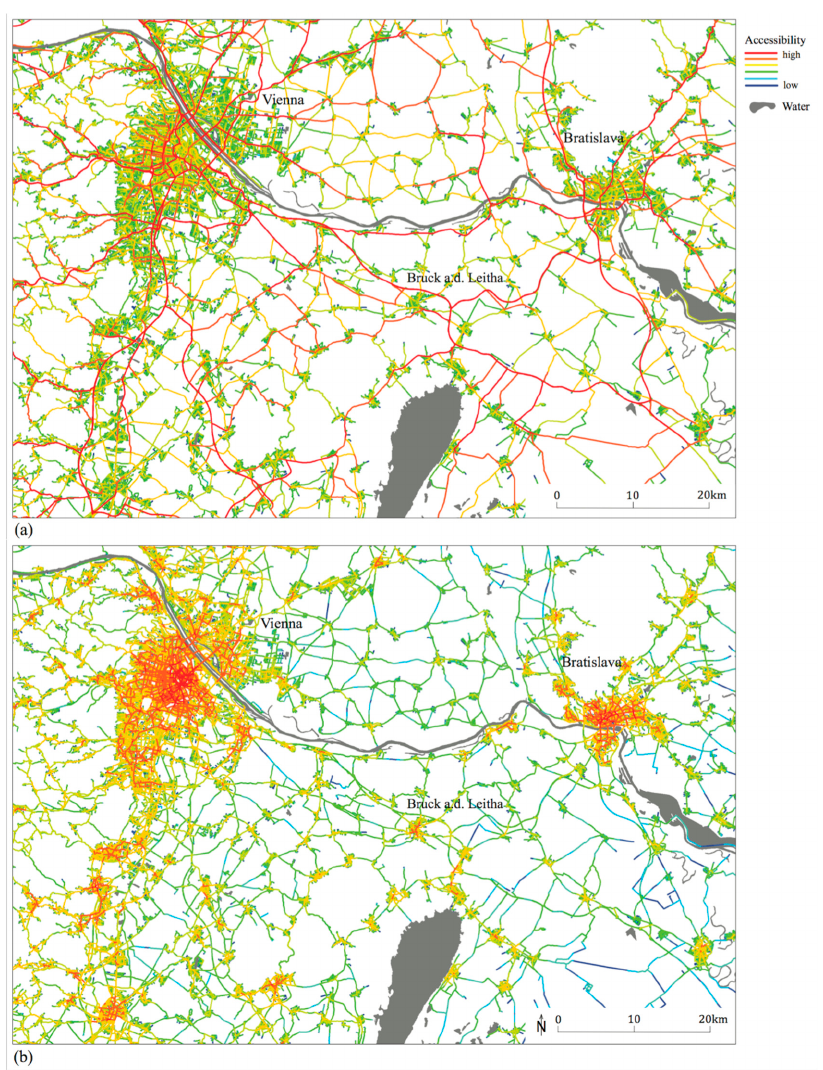
Figure 4. Geometric accessibility analysis using the road network: ( a ) Normalized choice high metrics determines the overall spatial strategy implemented for developing scenarios on a regional scale; and ( b ) normalized choice low metrics—2000 m depicts local centers.